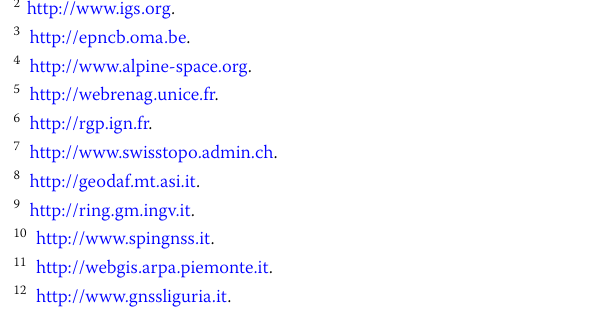
Figure 1b represents a zoomed image of the French– Italian border area in which the PSs are denser and have an average spacing of ~ 40